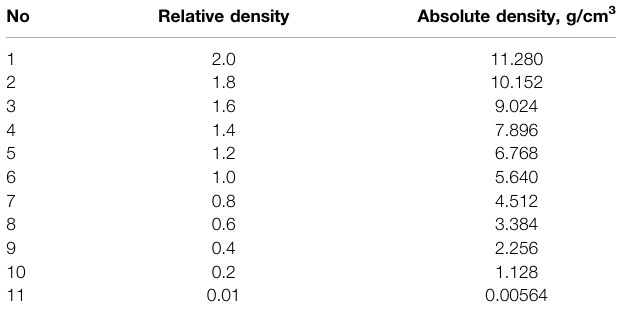
TABLE 4 | ZrH 1.6 density variation.